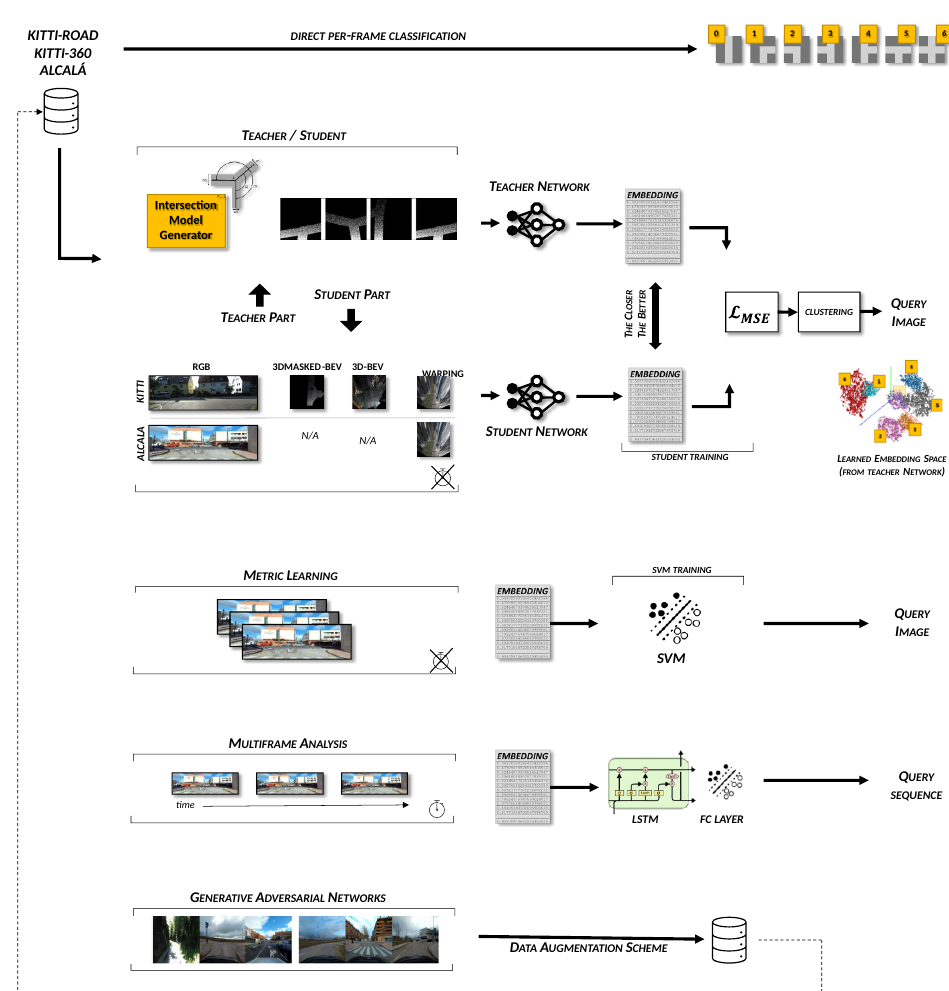
Figure 6. The picture includes all the approaches presented in this work, including Direct per-frame classification (Section 4.1), Teacher/Student (Section 4.4), Metric Learning (Section 4.2), and Multi- frame analysis (Section 4.5), together with the GAN-based data augmentation scheme. As the reader can notice, all the approaches except the direct per-frame classification involve using embedding vectors obtained from DNN systems, which in turn are further processed using the techniques described in the remainder of this work. The clock symbol indicates when a time-series analysis is involved. BAL